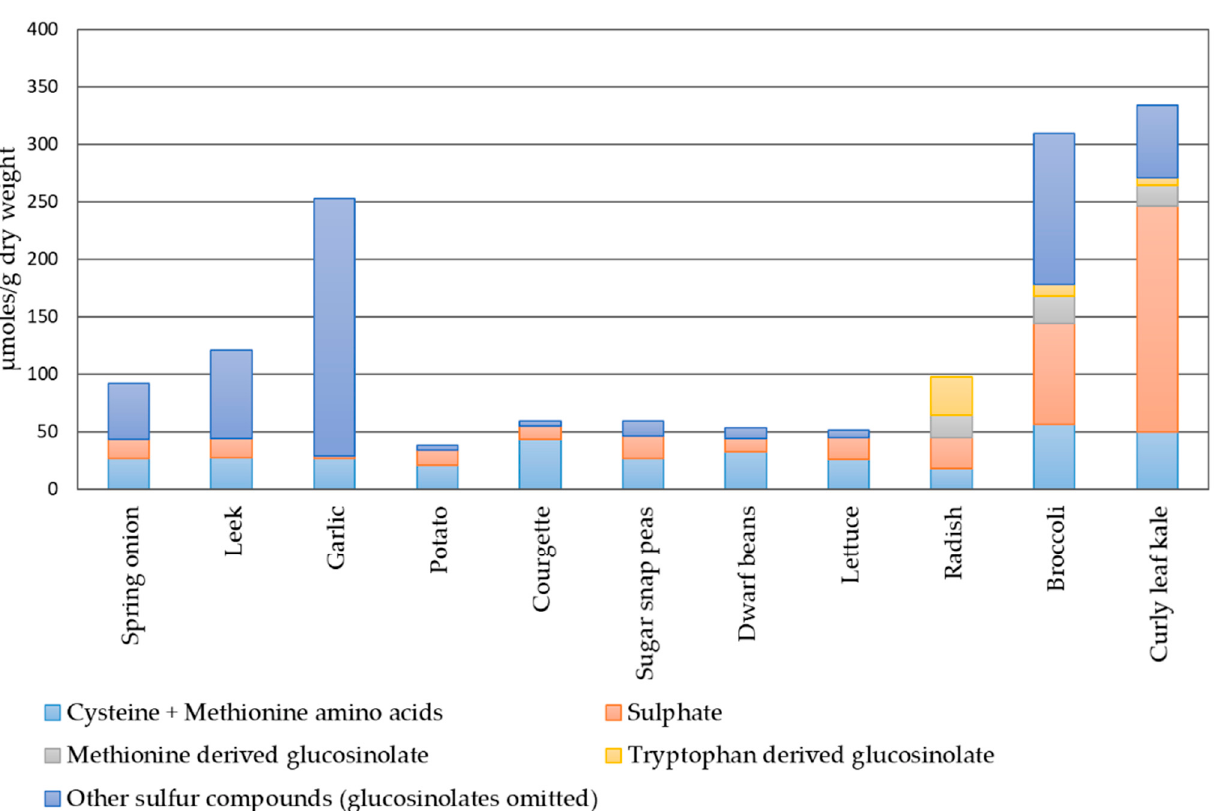
Figure 2. Sulfur distribution in selected vegetables based on [35].